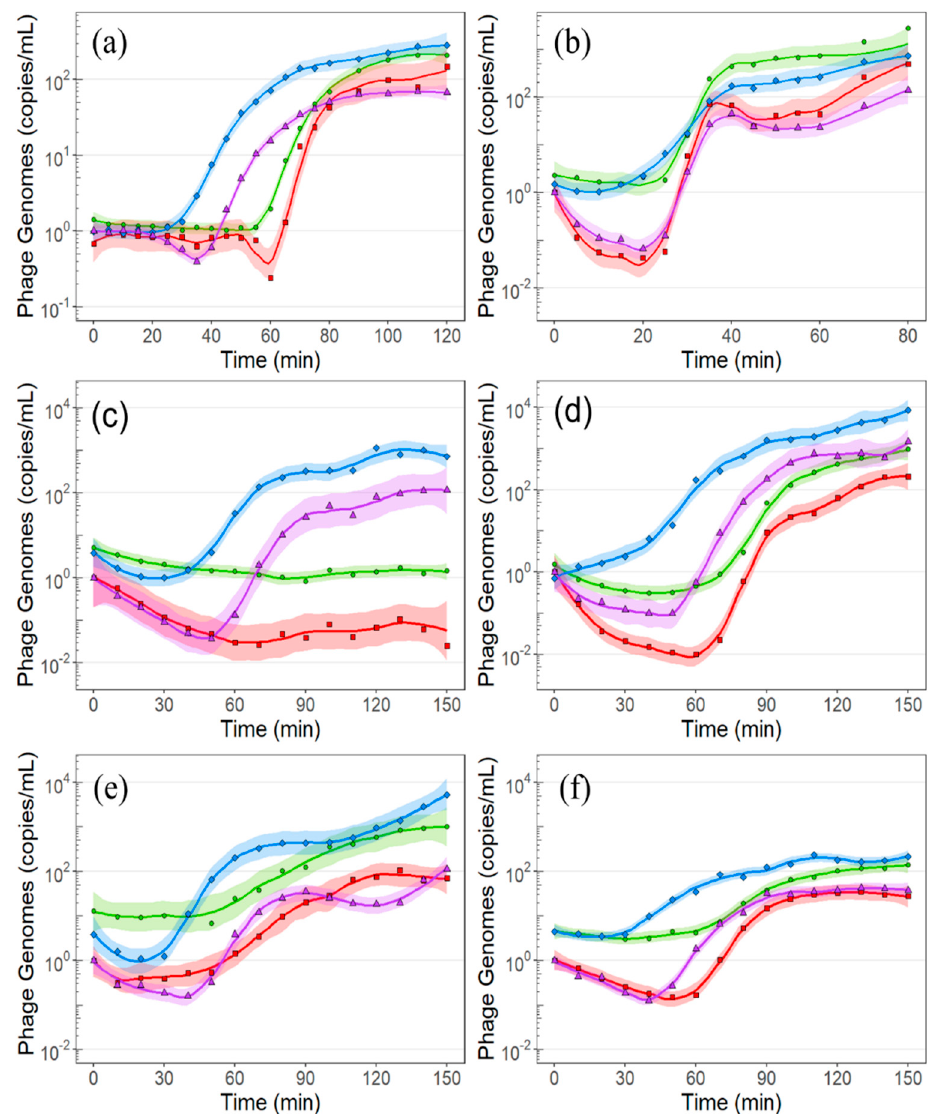
Figure 4. Molecular profile of phage infection of the four genera of Erwinia phages in this study. ( a ) Infection of E. amylovora Ea6-4 by phage Φ Ea21-4 at an multiplicity of infection (MOI) of 0.45. ( b ) Infection of E. amylovora EaD7 by phage Φ Ea46-1-A1 at an MOI of 0.625. ( c ) Infection of E. amylovora Ea17-1-1 by phage Φ Ea9-2 at an MOI of 0.015. ( d ) Infection of E. amylovora Ea273 by phage Φ Ea9-2 at an MOI of 0.015. ( e ) Infection of P. agglomerans Pa39-7 by phage Φ Ea35-70 at an MOI of 0.03. ( f ) Infection of P. agglomerans Pa39-7 by phage Φ Ea35-70 at an MOI of 0.7. The symbols represent the mean of data produced in triplicate, the line is a local regression model of the data (LOESS), and the shaded area around the line represents a 95% confidence interval. MOIs were calculated using the qPCR data at t 0 . Here, (blue diamond) = total number of phage genomes; (green circle) = total number of phage genomes in the supernatant; (purple triangle = total number of virions; (red square = total number of virions in the supernatant. Table 1. Infection characteristics of the lytic cycle as determined through the molecular profile of phage infection. Lytic Cycle Stage Genomic Adsorption A Infection B Rep. Rep. Rep.